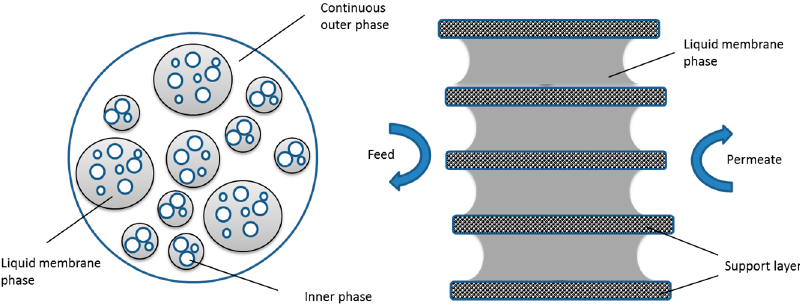
Figure 18. Schematic diagram of liquid membrane with an emulsion ( left ) and immobilized lamellae ( right ).